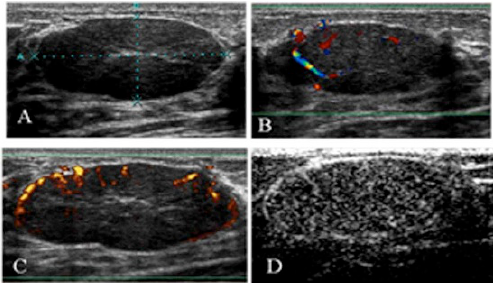
Figure 4 - Juvenile fibroadenoma in the left breast of an 18-year- old woman. A) A gray-scale image showing an oval, circum- scribed mass (BI-RADS 3). B) A color Doppler image showing a hypervascular lesion with central and regular arteries. C) An enhanced color Doppler image showed the same pattern as the unenhanced CDUS. Power Doppler imaging was used only to produce clearer images for illustration purposes. D) After contrast injection, there was intense enhancement.